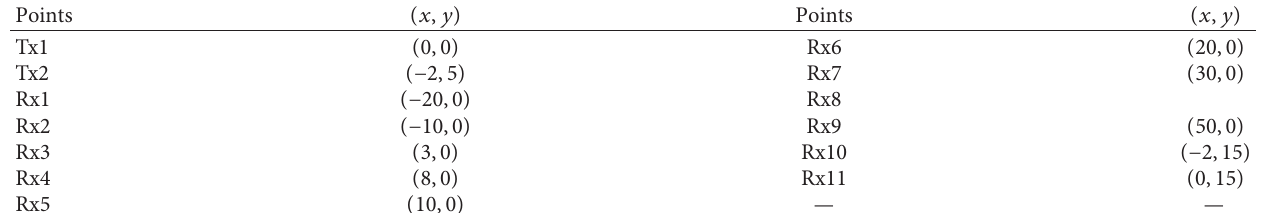
Table 2: Coordinates of test points.